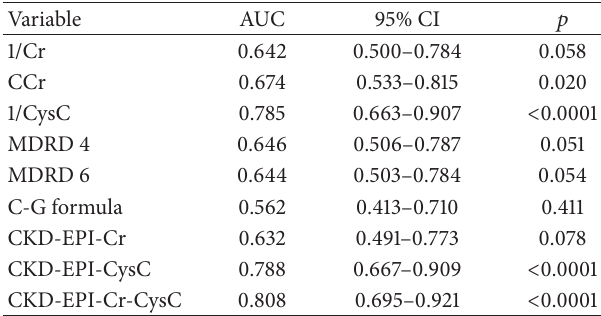
Table 5: Area under the curve for detecting early renal impairment for studied tests and